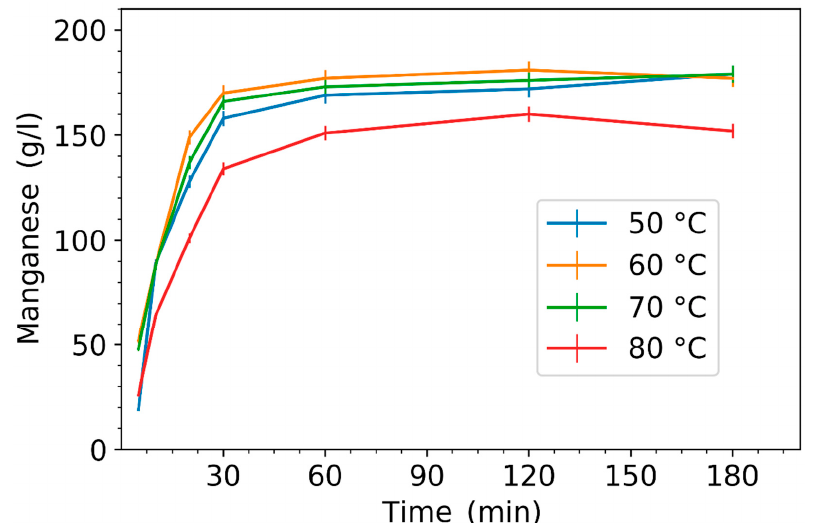
Figure 2. Manganese concentration as a function of time at 50, 60, 70 and 80 ◦ C (solid-to-liquid (S / L) ratio 420 g / L, Citric